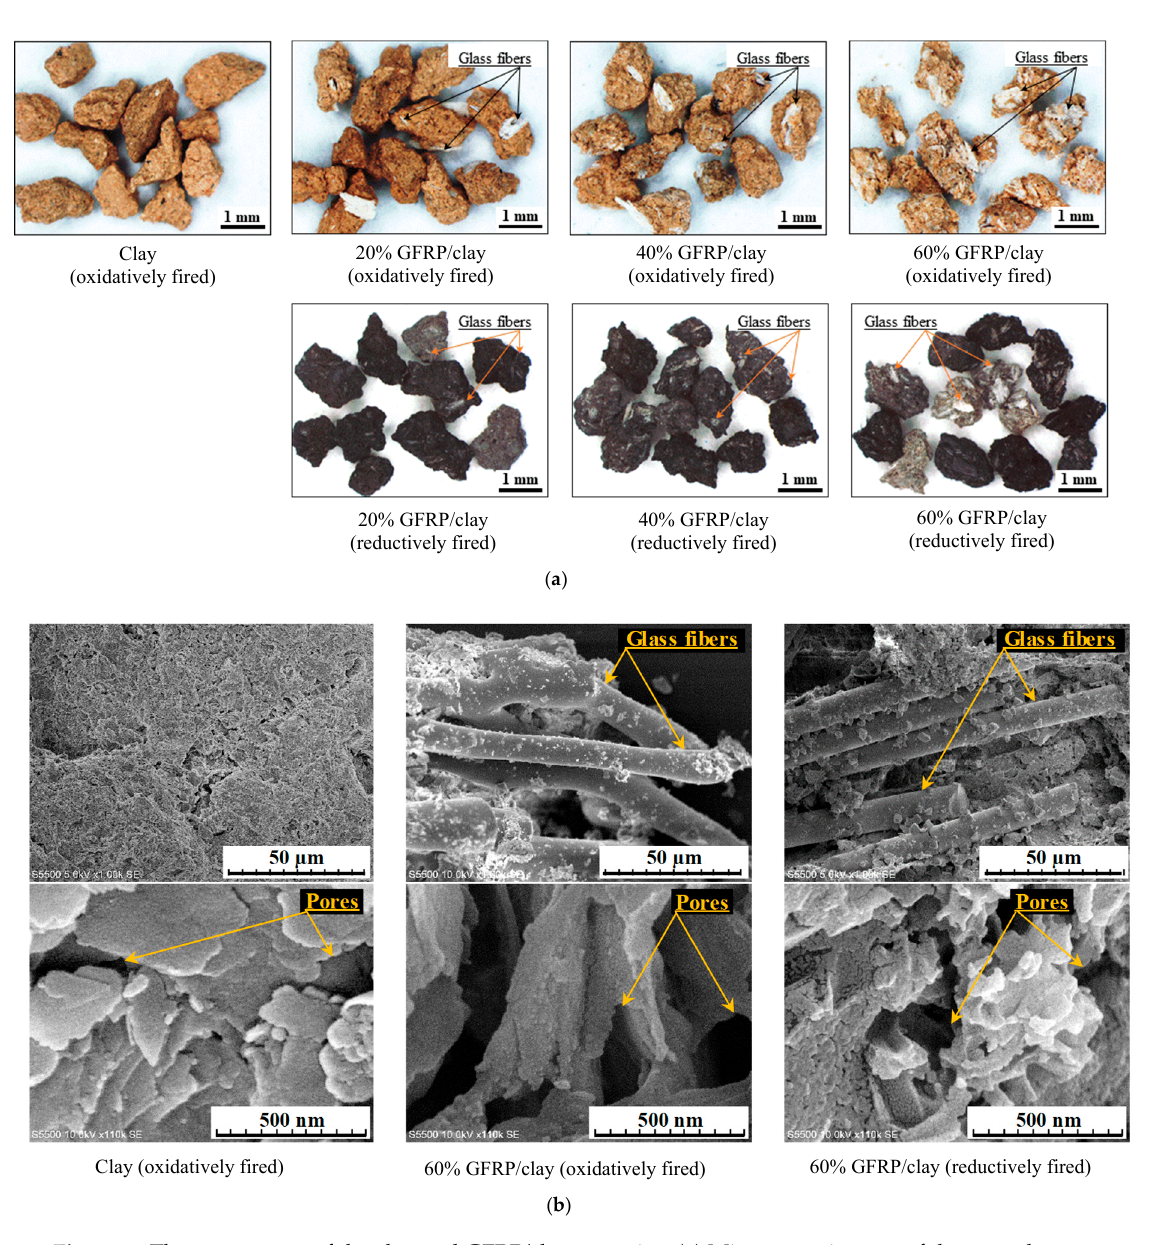
Figure 2. The appearance of the clay and GFRP / clay ceramics. ( a ) Microscope images of the granular GFRP / clay ceramics. ( b ) SEM images of the GFRP / clay ceramic surface structures.